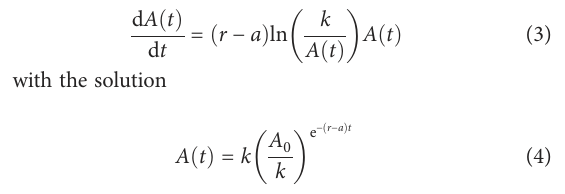
FIGURE 7 Images of ZR75 colonies (1 set) treated with various drug concentrations and combinations. Images are taken using an inverted microscope interfaced to LAS EZ software on 5th, 7th,9th, 12th, 14th, 17th, and 19th day after seeding. White arrow marks show the colonies. Images are calibrated (scale bar=100 m m) using LAZ EZ software. Images for higher concentrations (H25P10, H25P20, and H50P20) are not shown as the growth inhibition is close to 100%. Shadows (dark line) of the markings made underneath the 6-well plate to track the colonies are also seen in most of the